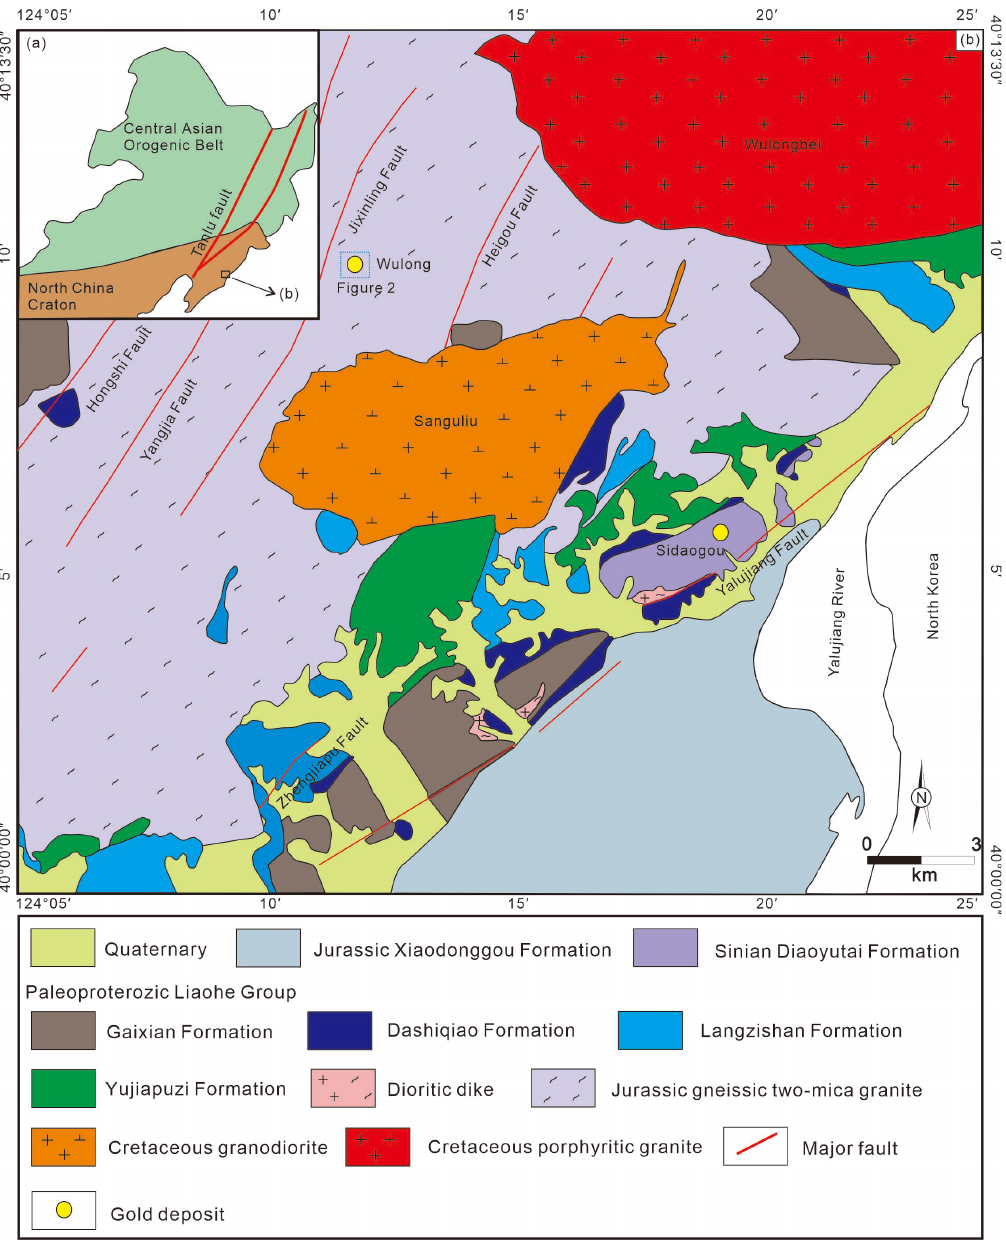
Figure 1. Simplified tectonic maps of ( a ) Liaodong Peninsula, showing the major faults and tectonic blocks; ( b ) Regional geologic map of the Wulong orefield. Modified from [12].